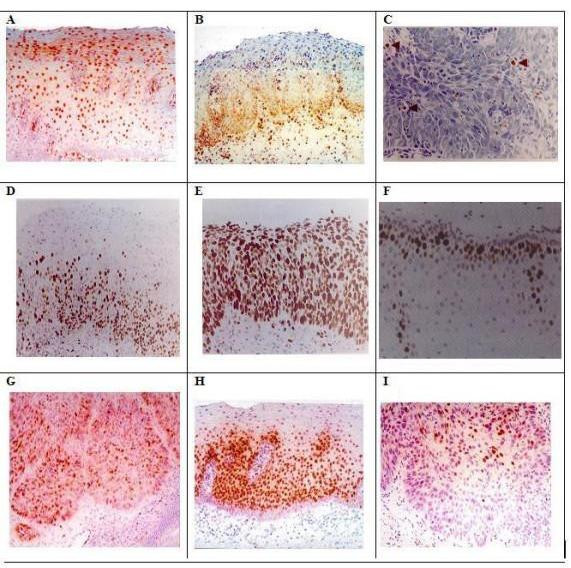
a) Positive immunostaining for p27KIP1 in the nuclei of normal cervical tissue, b) positive immunostaining for p27KIP1 in CINI, c) lack of p27KIP1 immunostaining in a case of invasive squamous cell carcinoma, d) positive immunostaining for p16INK4A in a case of CINII, e) positive immunostaining for p16INK4A in a case of III, f) negative nuclear imminostaining for cyclinD1 in normal cervical tissue except in the parabasal cells, g) a strongly positive immunostaining for cyclinD1 in a case of invasive squamous cell carcinoma, h) positive nuclear immunostaining for Rb in parabasal and intermediate squamous cells in hyperplastic squamous epithelium, and i) focal and weak nuclear staining for Rb in a case of invasive squamous cell carcinoma.